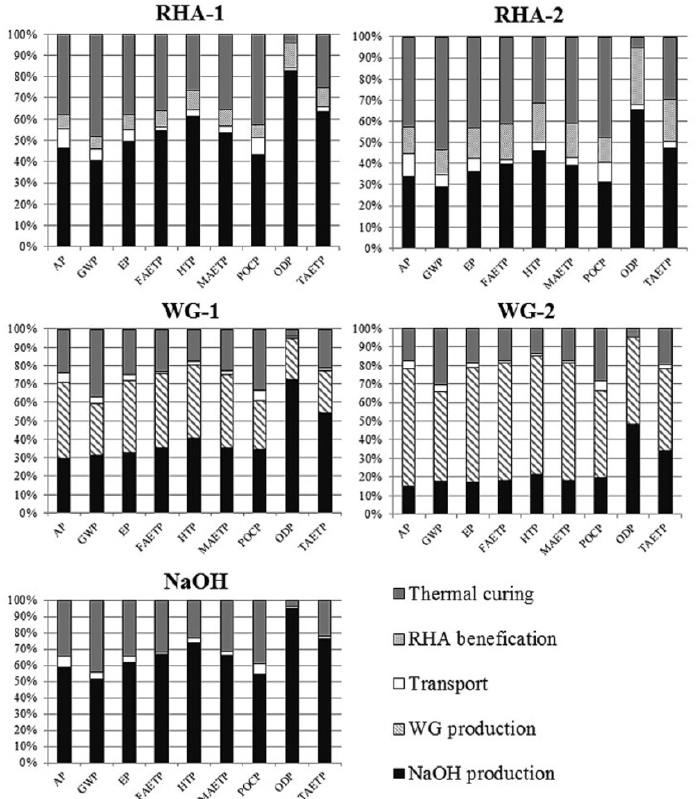
Figure 6. Contribution of heat curing to the LCA results of the binders where precursor was CKS and AAs were SH, RHA-1/WGP-1, and RHA-2/WGP-2, representing the combination of RHA/WGP, SH, and water with different SiO 2 /Al 2 O 3 molar ratios of 3.5 and 4.05, respectively [118].